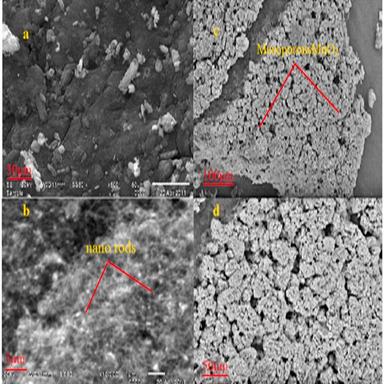
(a, b) SEM of MWCNT, (c, d) SEM of mesoporous (MnO2/MWCNT).